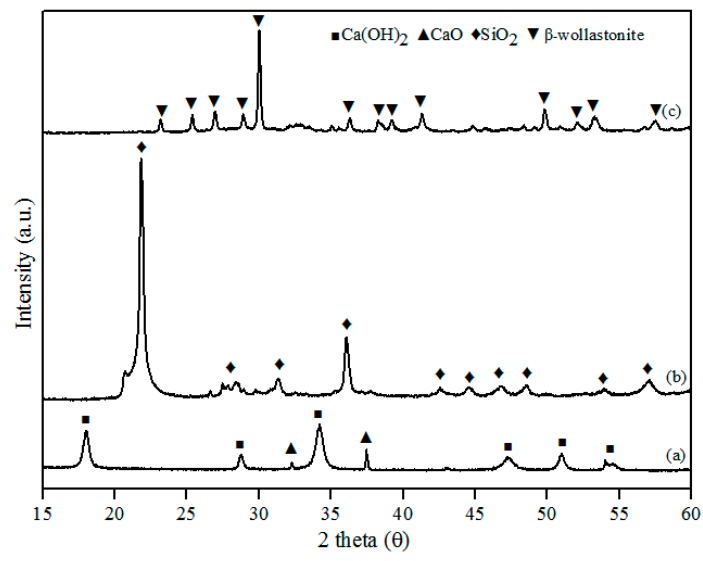
Figure 1. X-ray diffraction (XRD) patterns for ( a ) calcined limestone; ( b ) rice husk ash; and ( c ) β - wollastonite.